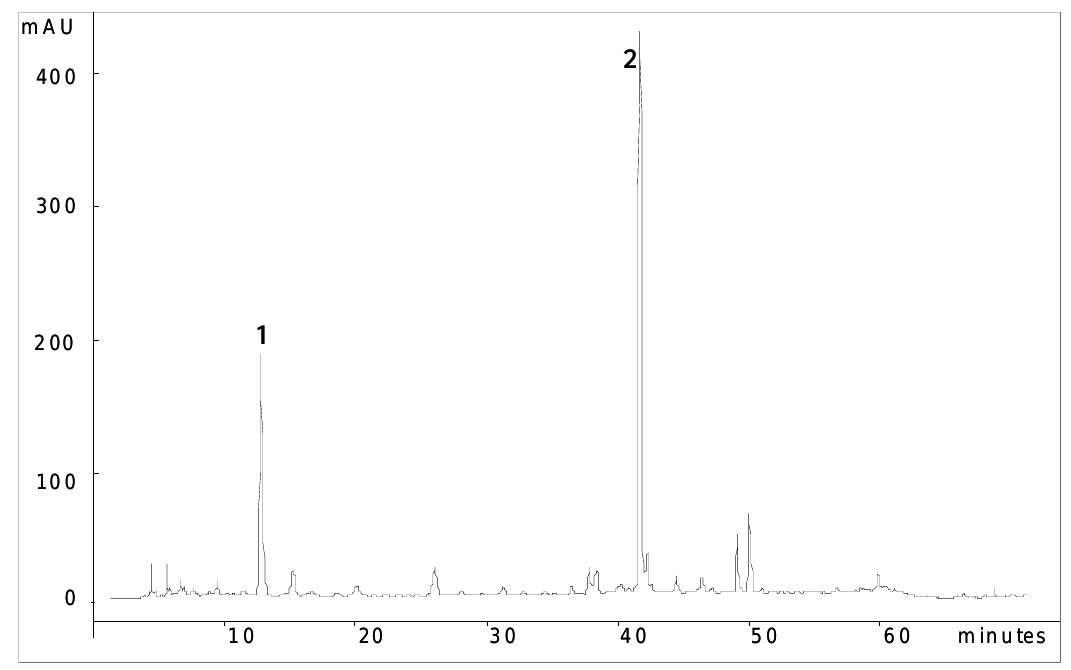
Figure 4 . HPLC-UV-PDA fingerprint of the AD of Mangifera indica leaves 1: benzophenone glycoside; 2: mangiferin. Detection at 254 nm. Chromatographic conditions: see